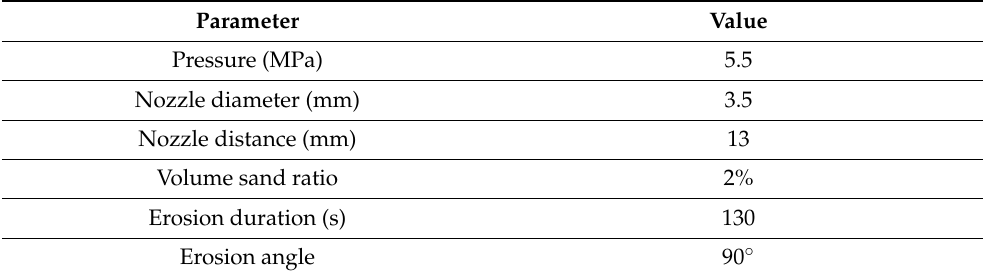
Table 3. Coupon unit erosion test working parameters.